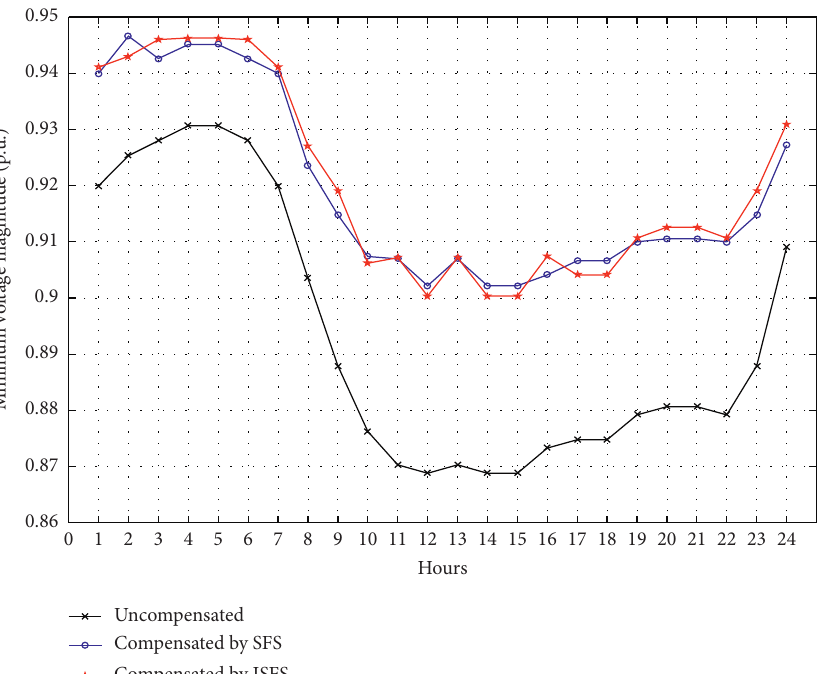
Figure 23: Minimum bus voltages of 119-bus network within 24-hour interval before and after compensation in scenario 2.